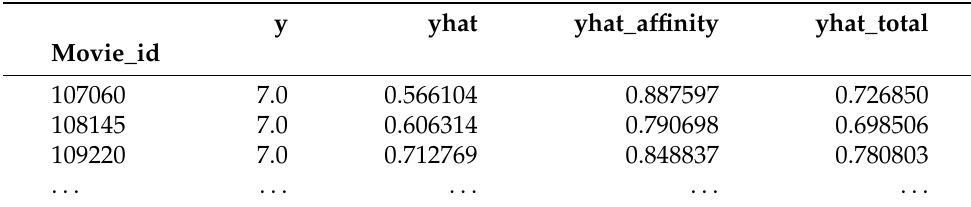
Table 6. Dataframe predictions for a user where the predictions for the selected user are displayed. The shape is (585, 4), where 585 is the number of movies rated by the user from the movie set, and 4 is the number of columns added for predictions.